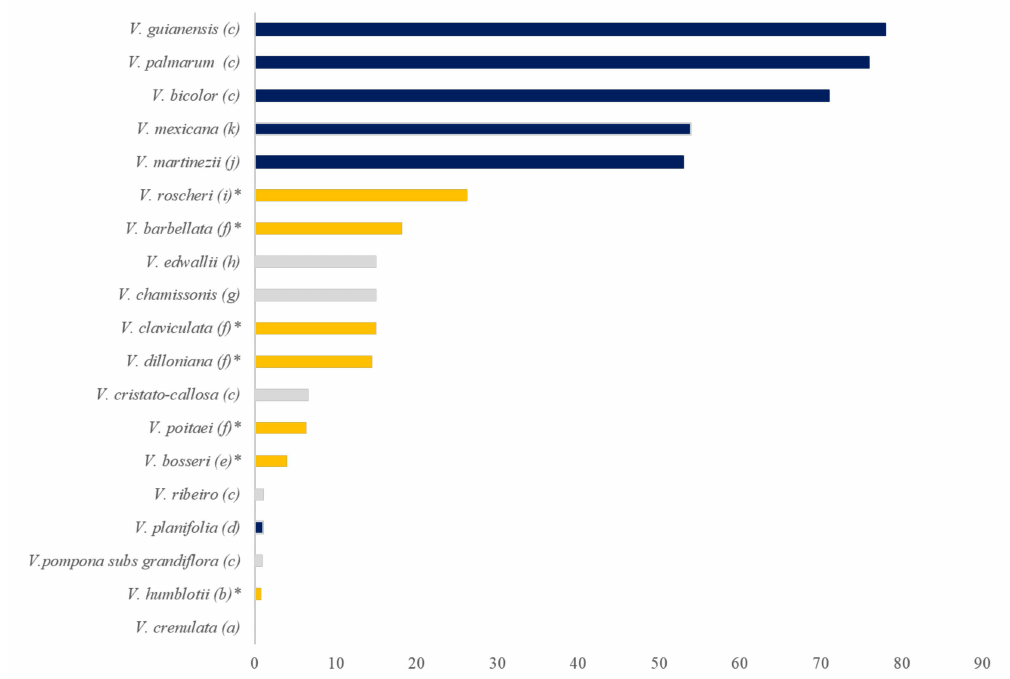
Figure 4. Rate of natural fruit set (%) of Vanilla species according to ( a ) Soto Arenas and Cameron [14], ( b ) Gigant et al. [21], ( c ) Householder et al. [42], ( d ) Ackerman et al. [54], ( e ) Petersson [53], ( f ) Tremblay et al. [45], ( g ) Macedo [55], ( h ) Pansarin, Aguiar, and Pansarin, 2014, ( i ) Gigant et al., 2014, ( j ) Soto Arenas and Dressler, 2010, ( k ) Gigant et al. [46]. Species that can self-pollinate spontaneously are in dark blue, leafless Vanilla species are in orange and indicated by *, and the grey bars represent the other